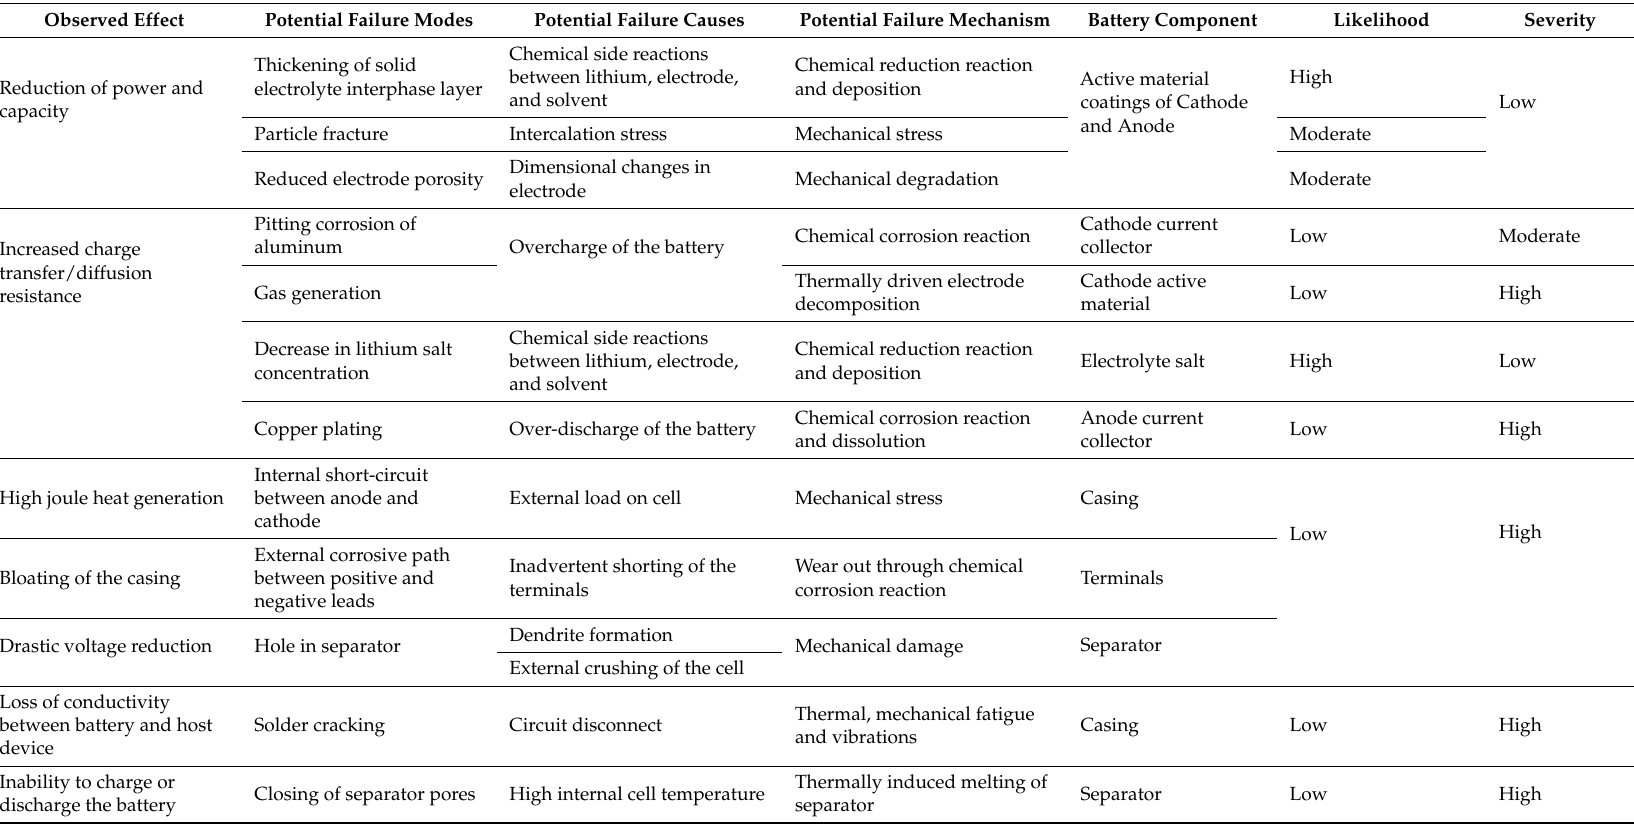
Table 1. Possible failure modes and mechanisms for a battery cell failure (based on the information available from